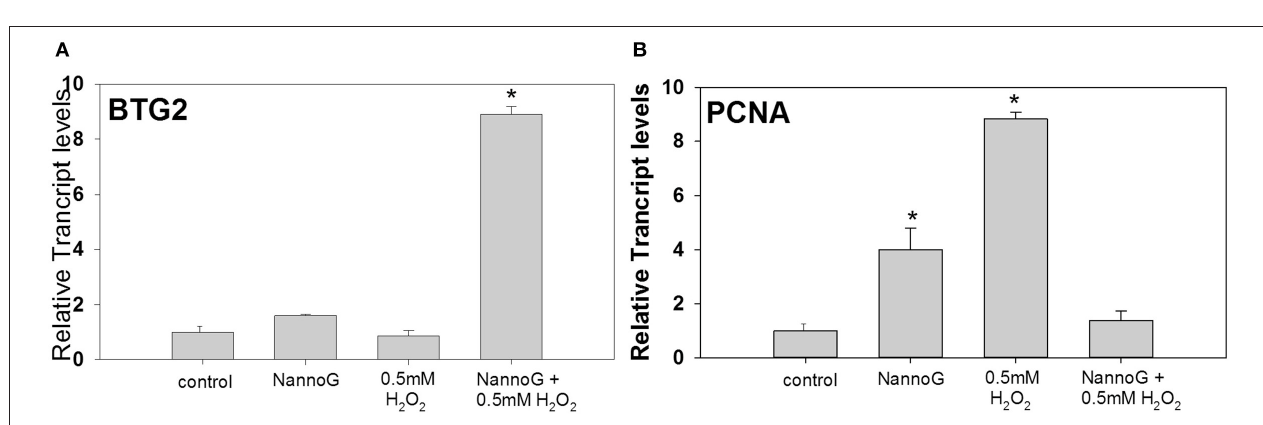
FIGURE 8 | Relative transcript accumulation of BTB2 (A) and PCNA (B) in comparison to control. The experimental conditions are: cells treated with H 2 O 2 0.5 mM, pre-treated cells with NannoG (408 µ g/ml), pre-treated cells with NannoG and stressed with H 2 O 2 (0.5 mM). * p < 0.05 significantly different from control.